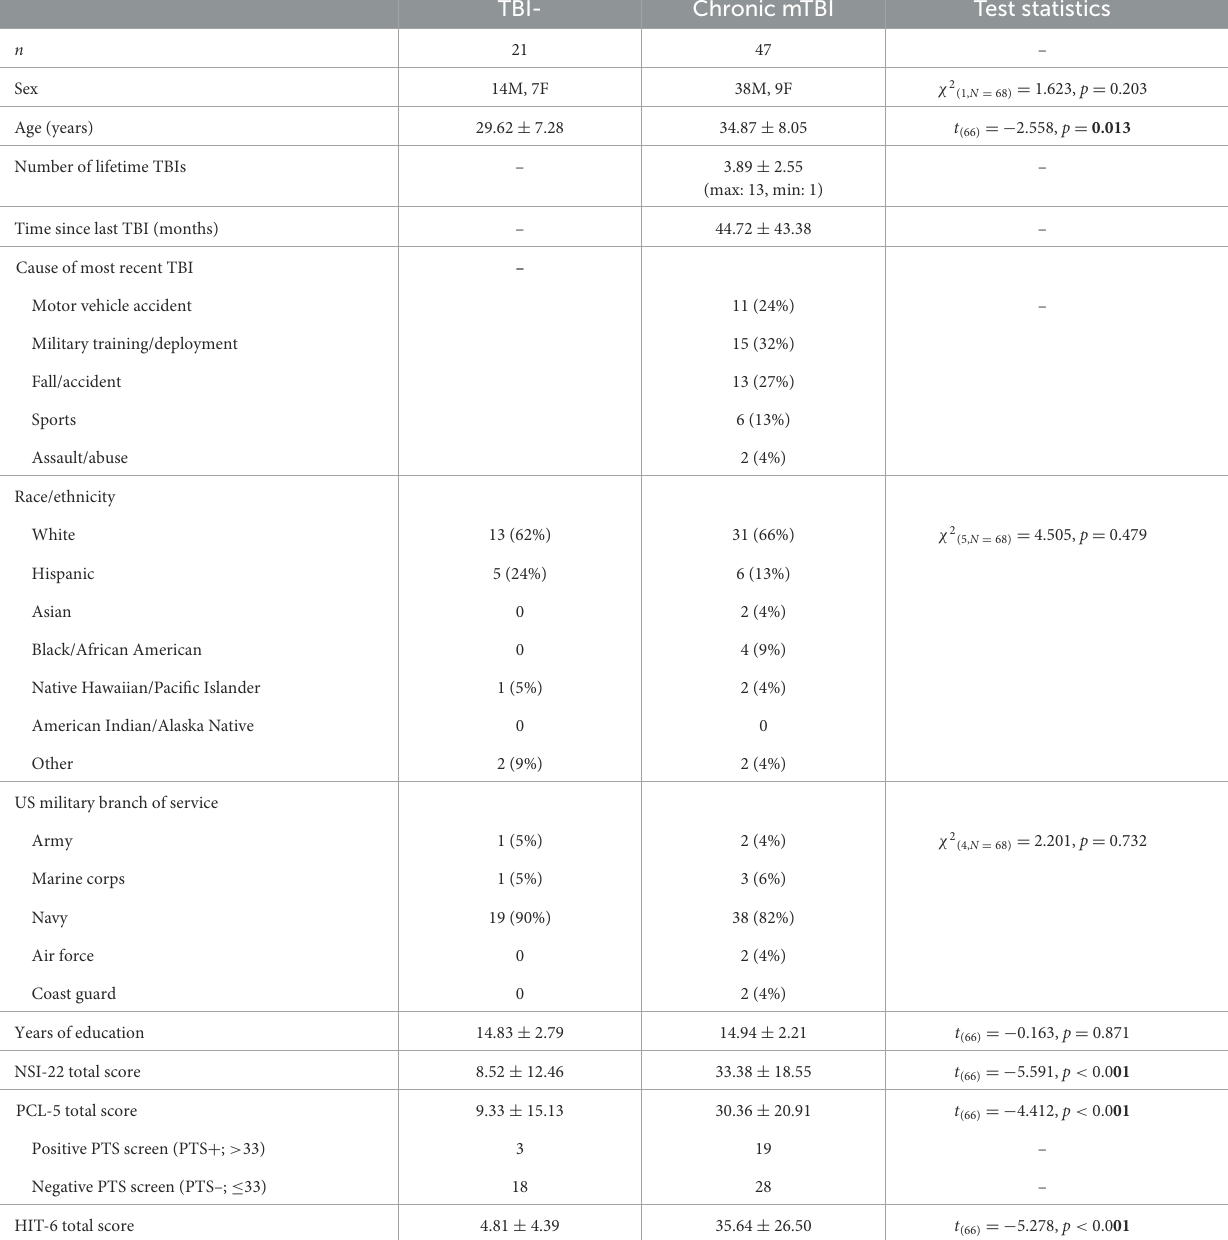
TABLE 1 Demographic and clinical